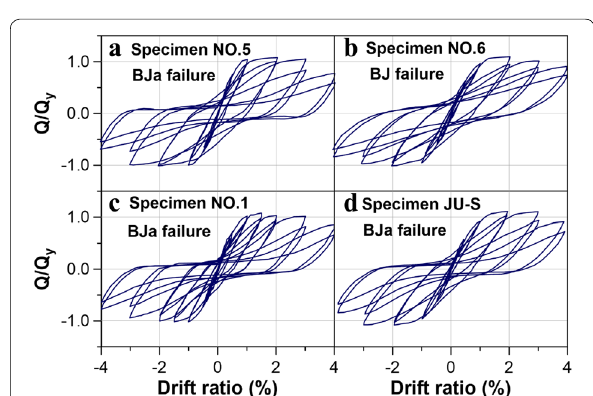
Fig. 6 Normalized column shear versus story drift for beam‑column joints with h c / d b ratios close to the proposed equation: a Specimen NO. 5; b Specimen NO. 6 tested by Nakachi and Tabata (1995); c Specimen NO. 1 tested by Hosoya et al. (2003); and d Specimen JU‑S tested by Yagenji et al.